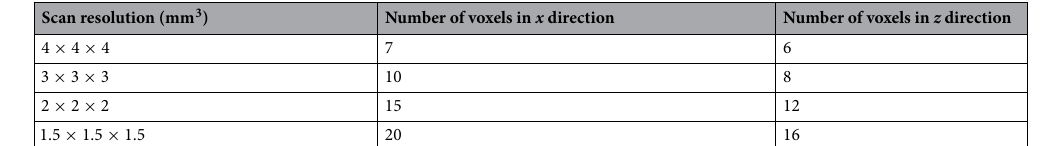
Scan resolution (mm 3 )